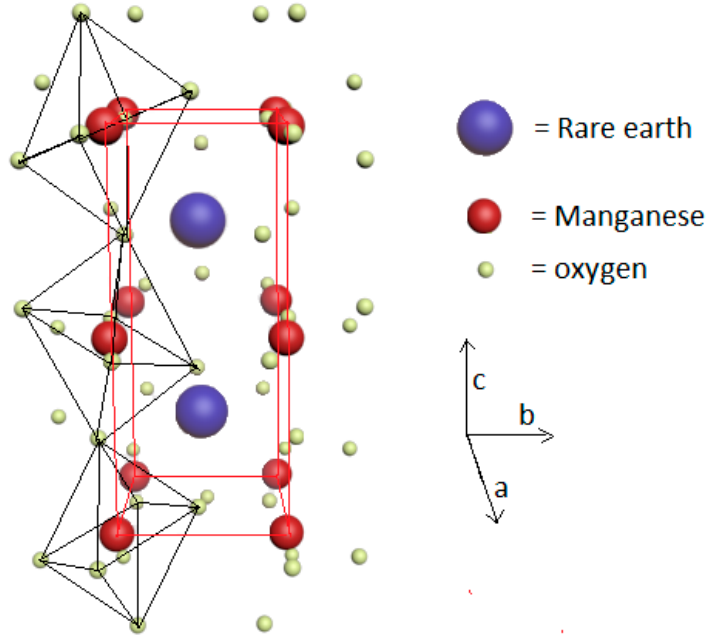
Figure 3. Perovskite orthorhombic structure of RMnO 3 . Smaller R 3+ radii will increase the oxygens’s octaedra tilting and ultimately will influence the super-exchange interaction mediating the ordering of Mn 3+ spins.